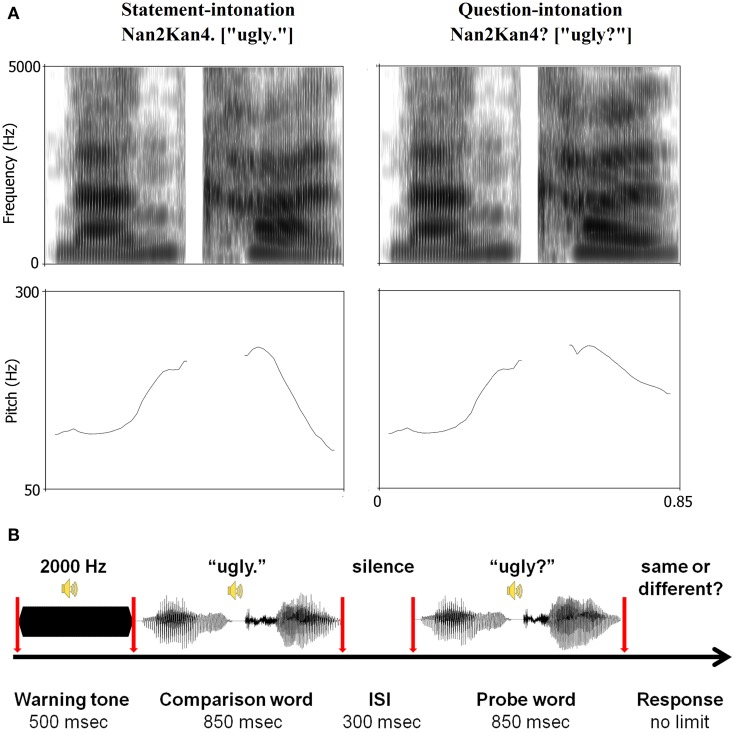
(A) Spectrogram and pitch contours of a pair of stimuli used in the task and (B) the scheme of trial timeline. The negative word “” (nan2kan4), which means “ugly,” as a statement (left panel) and a question (right panel). The mean F0 of statement- and question-intonation was identical in terms of the first syllable (positive words: M = 179.74 Hz, SD = 39.23 Hz; negative words: M = 194.35 Hz, SD = 80.56 Hz), but it was different in terms of the second syllable (positive statement: M = 170.57 Hz, SD = 62.76 Hz; positive question: M = 223.88 Hz, SD = 57.51 Hz; negative statement: M = 199.89 Hz, SD = 80.69 Hz; negative question: M = 226.64 Hz, SD = 64.77 Hz). All trials started with a 2000 Hz sinusoidal lasting for 500 ms. After the presentation of the comparison word (two 400 ms syllables with a 50 ms silence between them), a 300 ms silence was presented, followed by the probe word lasting for 850 ms. During the task, participants were asked to fixate on a white cross on a black screen. At the end of each trial, they were required to make a non-speeded response to indicate whether the intonation of the comparison and probe words was the same or different by pressing one of two response keys.